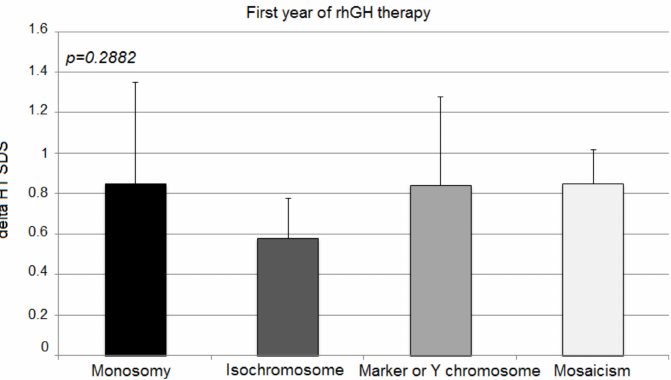
Figure 1. Growth response to rhGH during the first year of therapy. H1 SDS, height standard deviation score after 1 year of therapy. The ANOVA test was applied ( p >